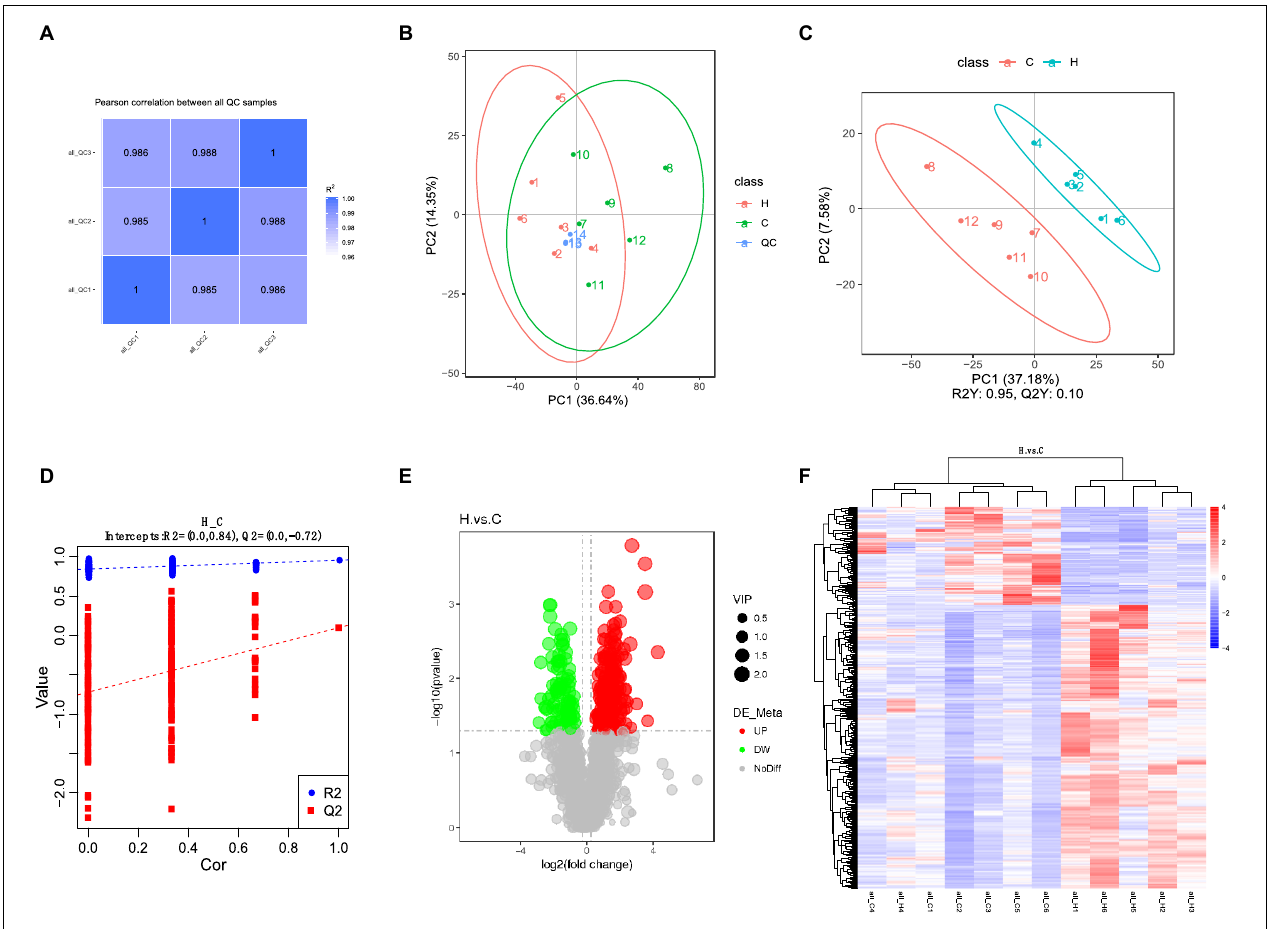
FIGURE 5 | Effect of HS on fecal metabolome of rabbits. (A) QC sample correlational analysis chart; (B) PCA value of the main sample; (C) PCA value of the principal component; (D) PLS-DA; (E) differential metabolite volcano map, the abscissa represents the difference multiple change (log 2 -fold change) of metabolites in different groups, and the ordinate represents the difference significance level (-log 10 p -value). Each point in the volcanic map represents a metabolite, the significantly upregulated metabolites are represented by red dots, the significantly downregulated metabolites are represented by green dots, and the size of the dot represents the VIP value; (F) cluster analysis of differential metabolites.